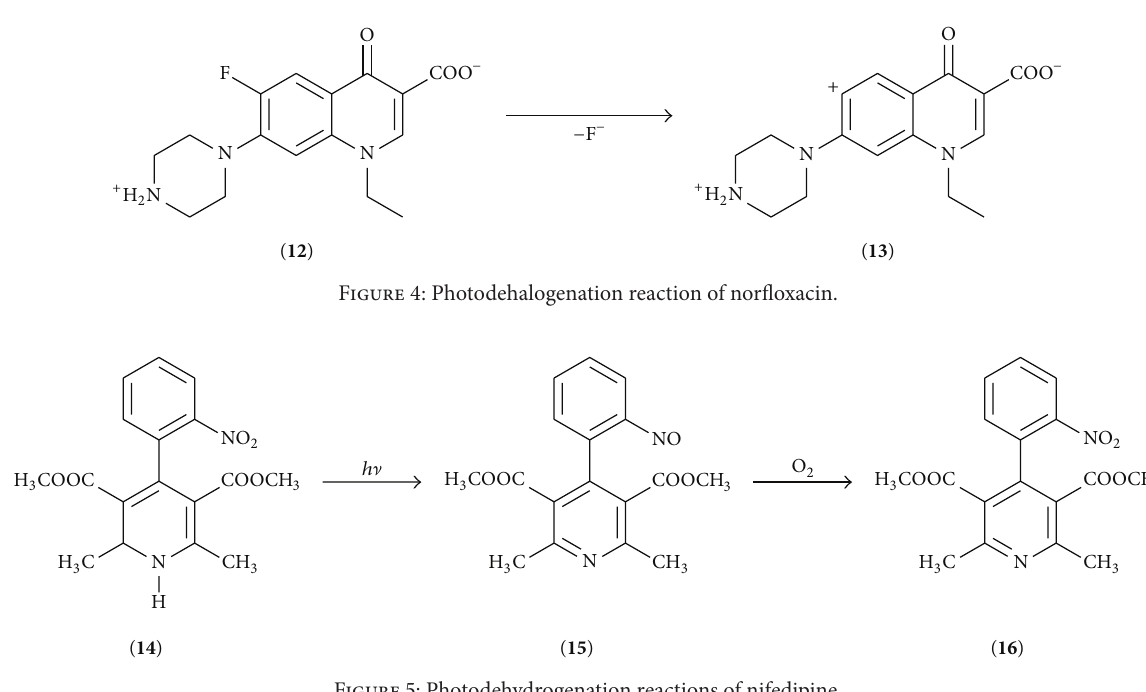
Figure 5: Photodehydrogenation reactions of